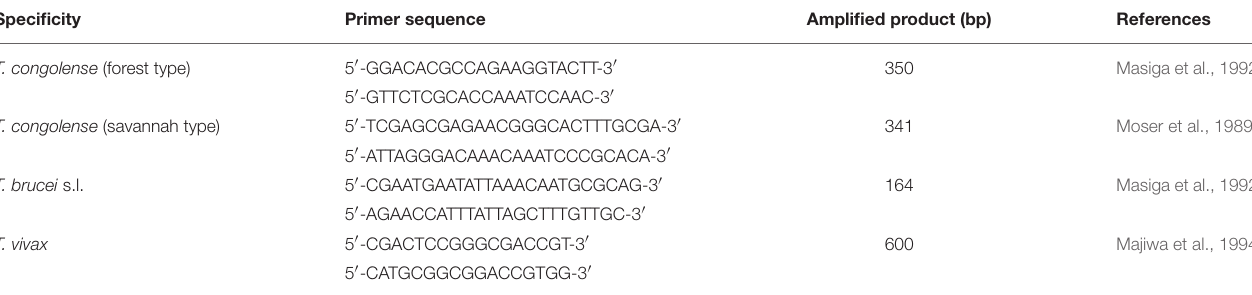
TABLE 1 | Primers used for PCR amplification of trypanosome DNA (Farikou et al., 2010a).